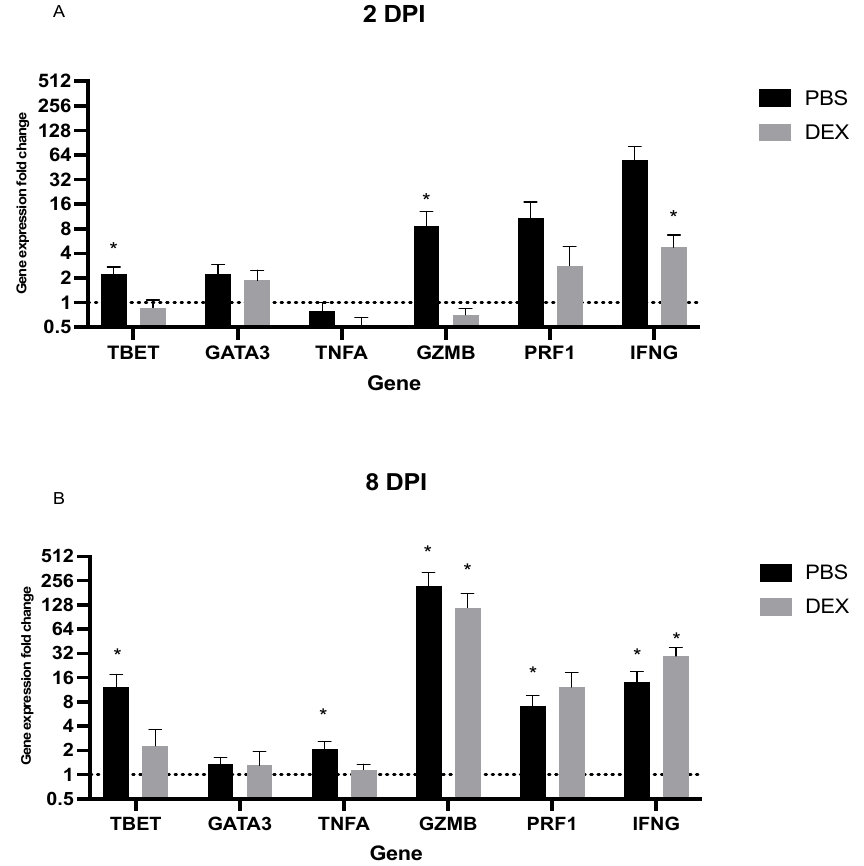
Figure 6. PCR lung transcript expression. Mouse lung transcript expression was performed from lungs of mice treated with PBS or 10 mg/kg DEX and infected with 10 3 PFU IBV were collected ( A ) 2 and ( B ) 8 days post-infection (dpi). Bars represent the mean +/ − SEM fold change of transcripts determined by ∆∆ Ct, normalized to ACTB, and uninfected, untreated controls, where * p < 0.05 by multiple Mann–Whitney U Tests.